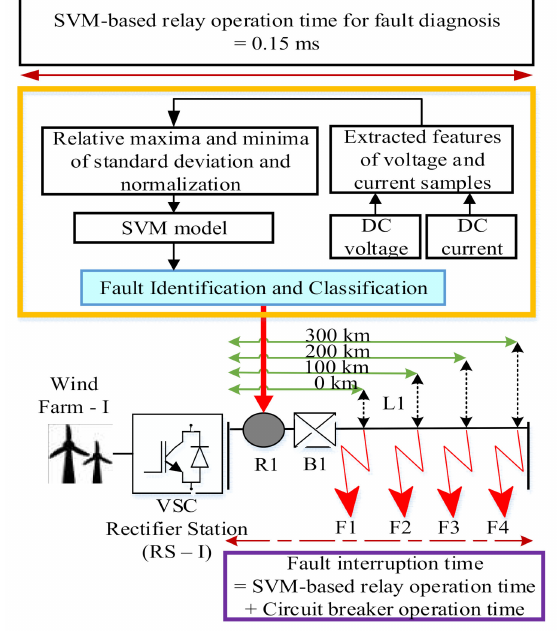
Figure 34. Applied structure of SVM-based protection technique. Table 4. Comparison of di ff erent protection techniques for MT-HVDC